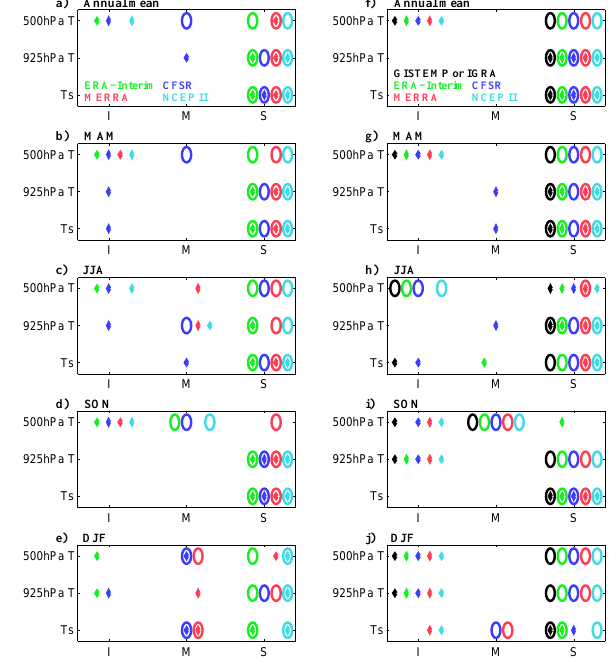
Fig. 10. Significance of the trends in Tables 3 and 4. Significance at the 95% level is indicated by an oval for the 1979–2011 trend and by a dot for the 1998–2011 trend. When an oval (or dot) is lo- cated above I, M or S, it means that the trend is insignificant, may be significant or is significant, respectively. We apply three differ- ent significance testing techniques. When all of the techniques es- tablish significance (or insignificance), we determine that the trend is significant (or insignificant). When the techniques give conflict- ing results, the trend is considered “maybe significant”. All tests are two-tailed tests. The left panels represent the significance of the trends from the true Arctic-mean time series while the right panels address the trends with only the reanalysis data corresponding to the available IGRA or GISTEMP